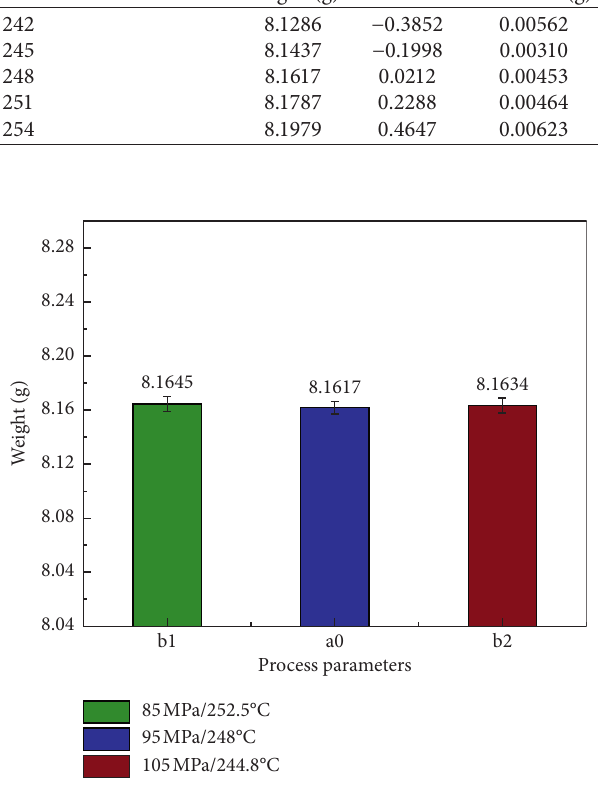
Table 3: Product weight under varying packing pressure. Packing pressure (MPa)